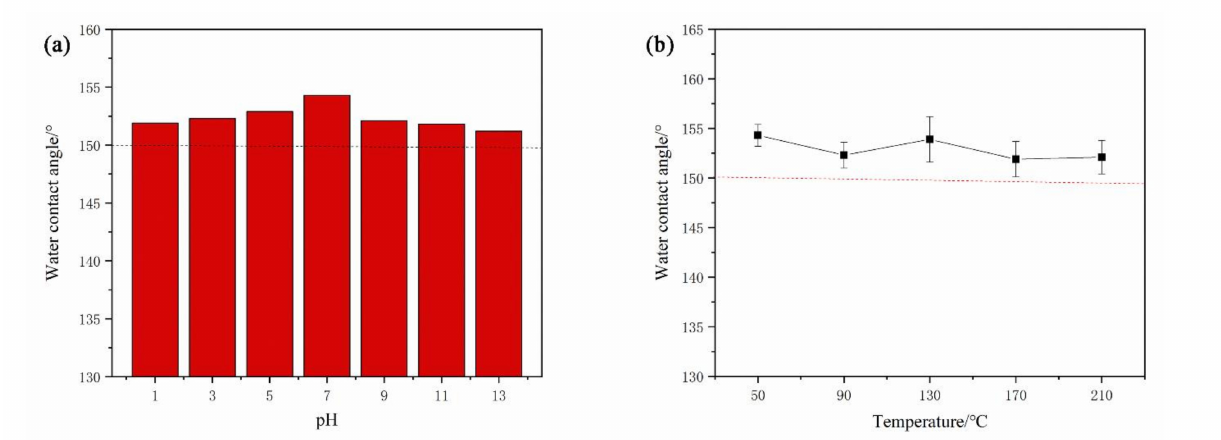
Figure 5. ( a ) CAs of different pH solutions; ( b ) CAs of superhydrophobic samples at different